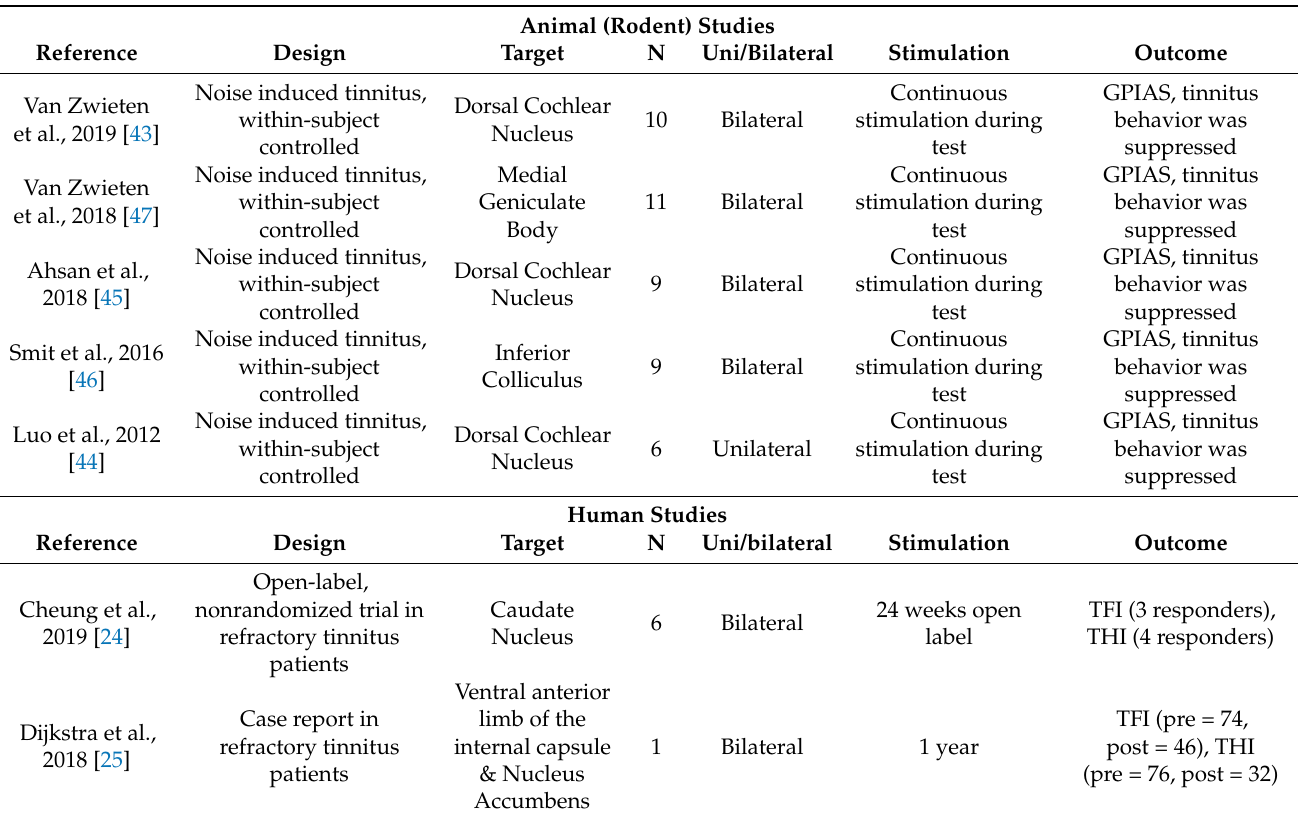
Table 1. Overview of preclinical and clinical DBS studies that applied DBS primarily for tinni- tus. We only listed studies that primarily treated tinnitus. GPIAS = gap-prepulse inhibition of the acoustic startle reflex; TFI = Tinnitus Functional Index (clinically significant change, i.e., respon- der = ≥ 13 point decrease); THI = Tinnitus Handicap Inventory (clinically significant change, i.e., responder = ≥ 20 point